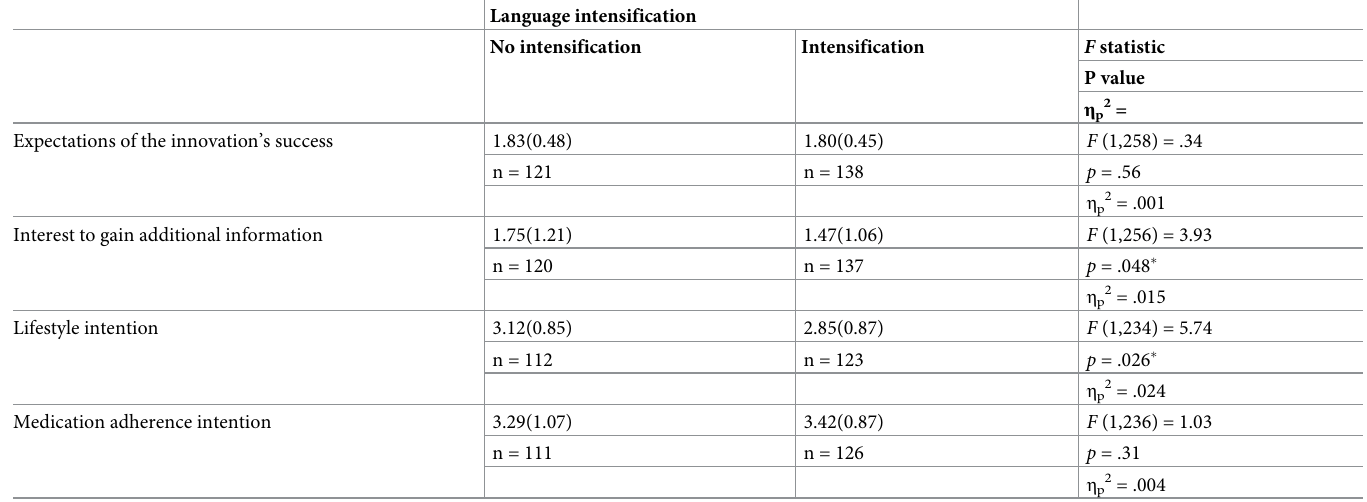
Table 6. Results one-way ANOVA: between group differences as filled in on a 5 point likert scale 0–4; mean/neutral = 2.0 (Language